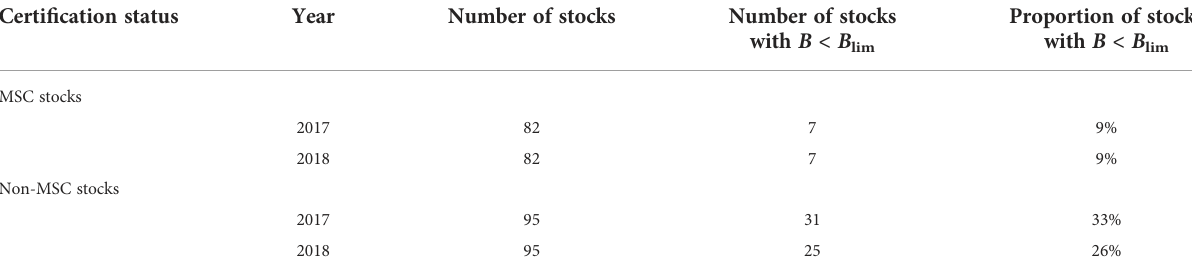
TABLE 2 Number and proportion of stocks with estimated biomass below limit reference point ( B < B lim ).